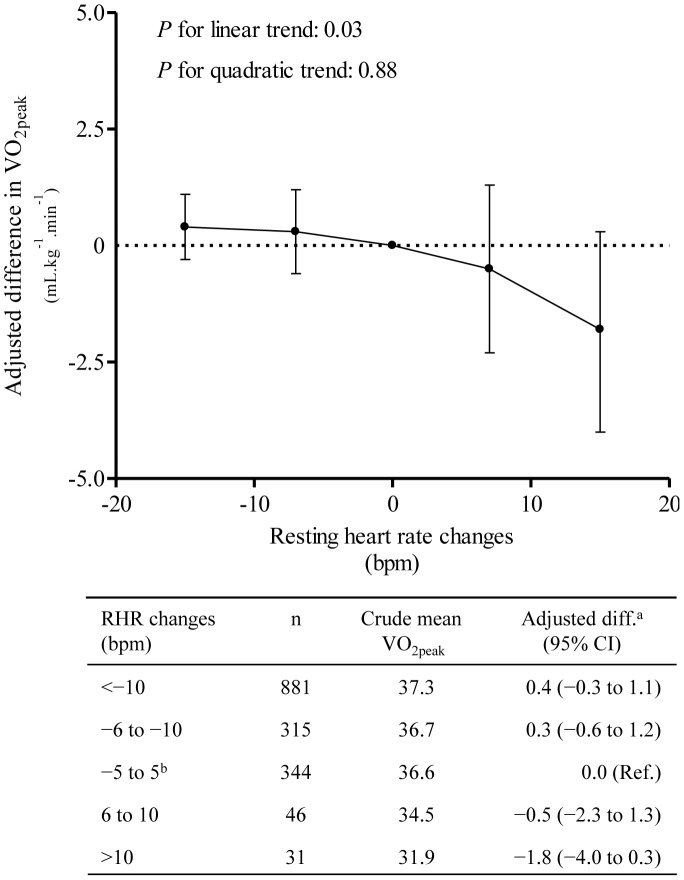
Difference in VO2peak by changes in resting heart rate.
aAdjusted for age, sex, weight change, physical activity index (inactive, low, medium and high), smoking status (never, current and former), education (<10, 10–12 and ≥13 years) and alcohol status-frequency last two weeks (0, 1–4, and ≥5 times). bReference group The circles represent adjusted difference, and bars represent 95% confidence intervals. VO2peak, peak oxygen uptake; RHR, resting heart rate; bpm, beats per minute.